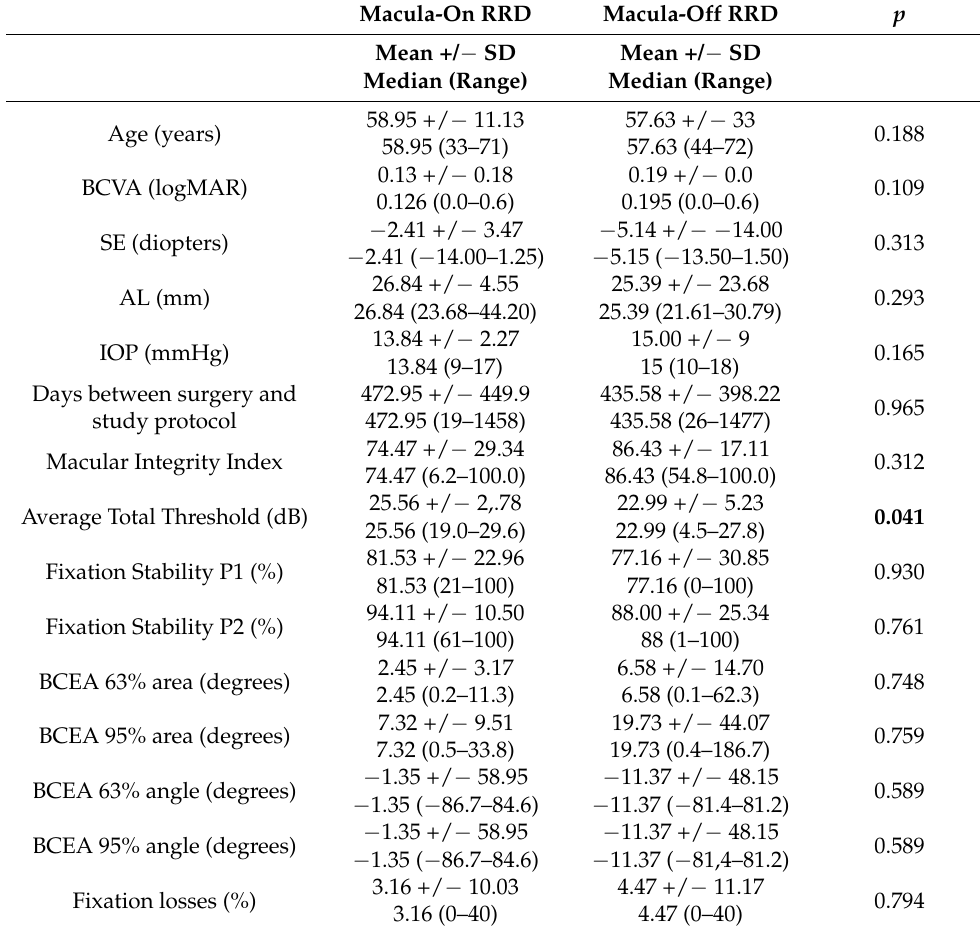
Table 4. Comparison for MAIA and clinical parameters between macula-on and -off subgroups. Significant differences ( p < 0.05) are highlighted in bold print. Macula-On RRD Macula-Off